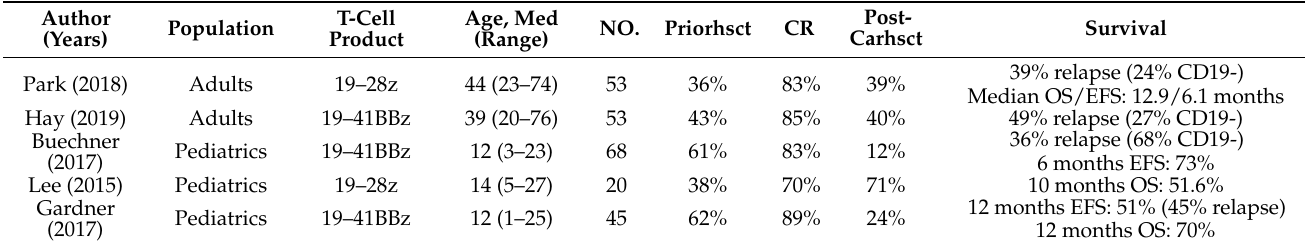
Table 2. Clinical efficacy of CD19 CAR T-cells in relapsed/refractory B acute lymphoblastic leukemia in the main clinical trials.